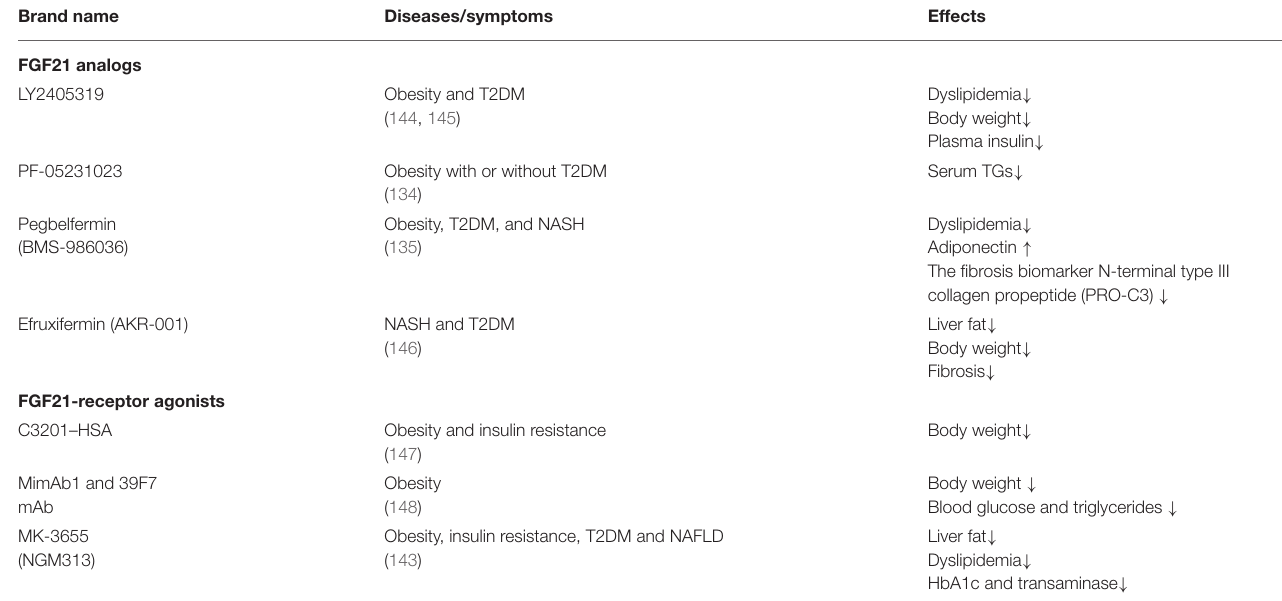
TABLE 1 | Pharmacological strategies to modulate the effects of FGF21 on related metabolic